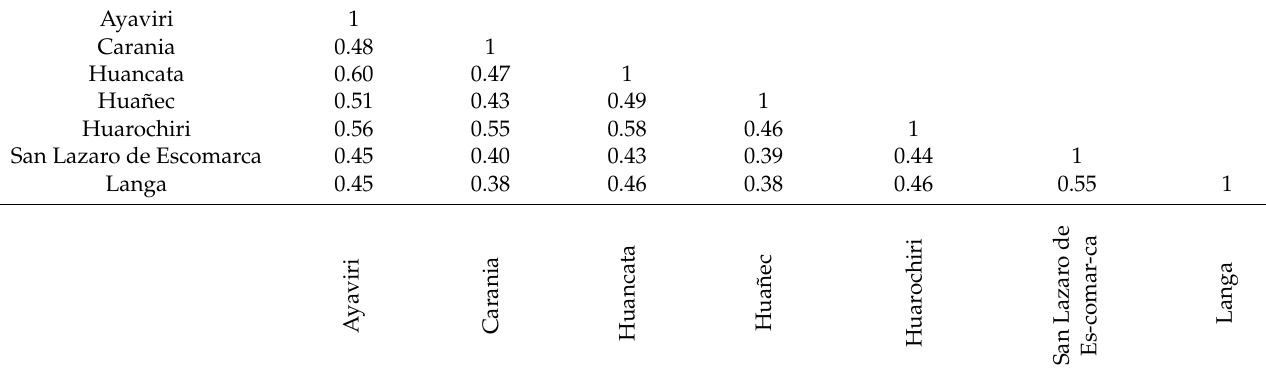
Table 4. Correlation coefficient—Region 1.